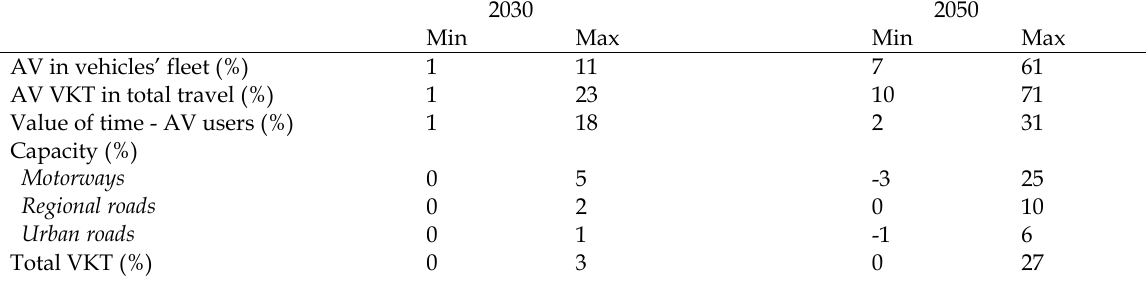
Table 4. Range of penetration rates and impacts of automated vehicles in the four